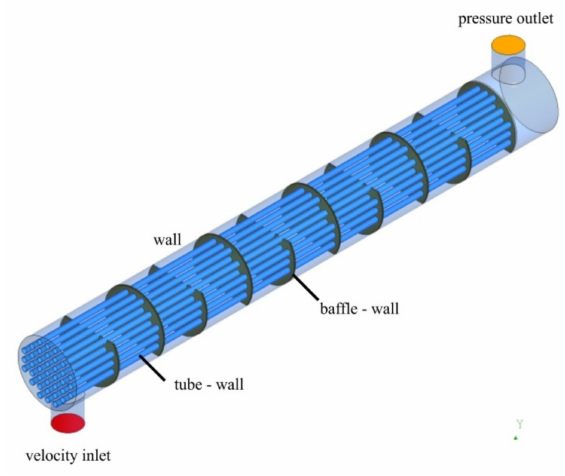
Figure 1. Isometric view of the computational